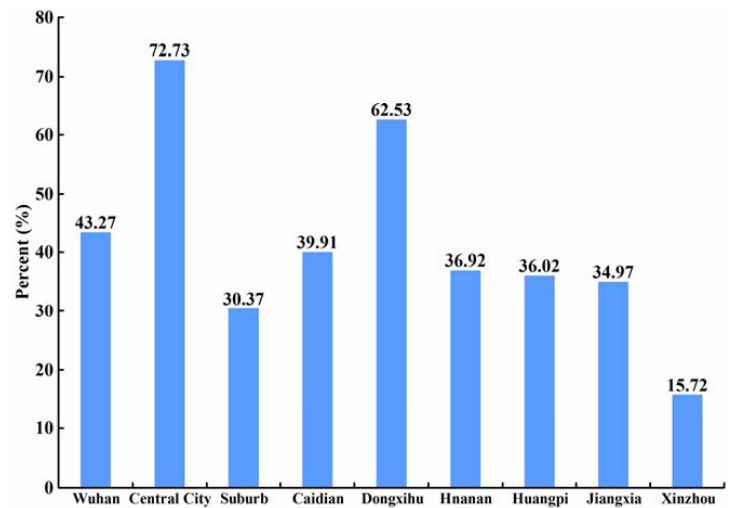
Figure 8. The proportion of private RACFs in the aged care service.